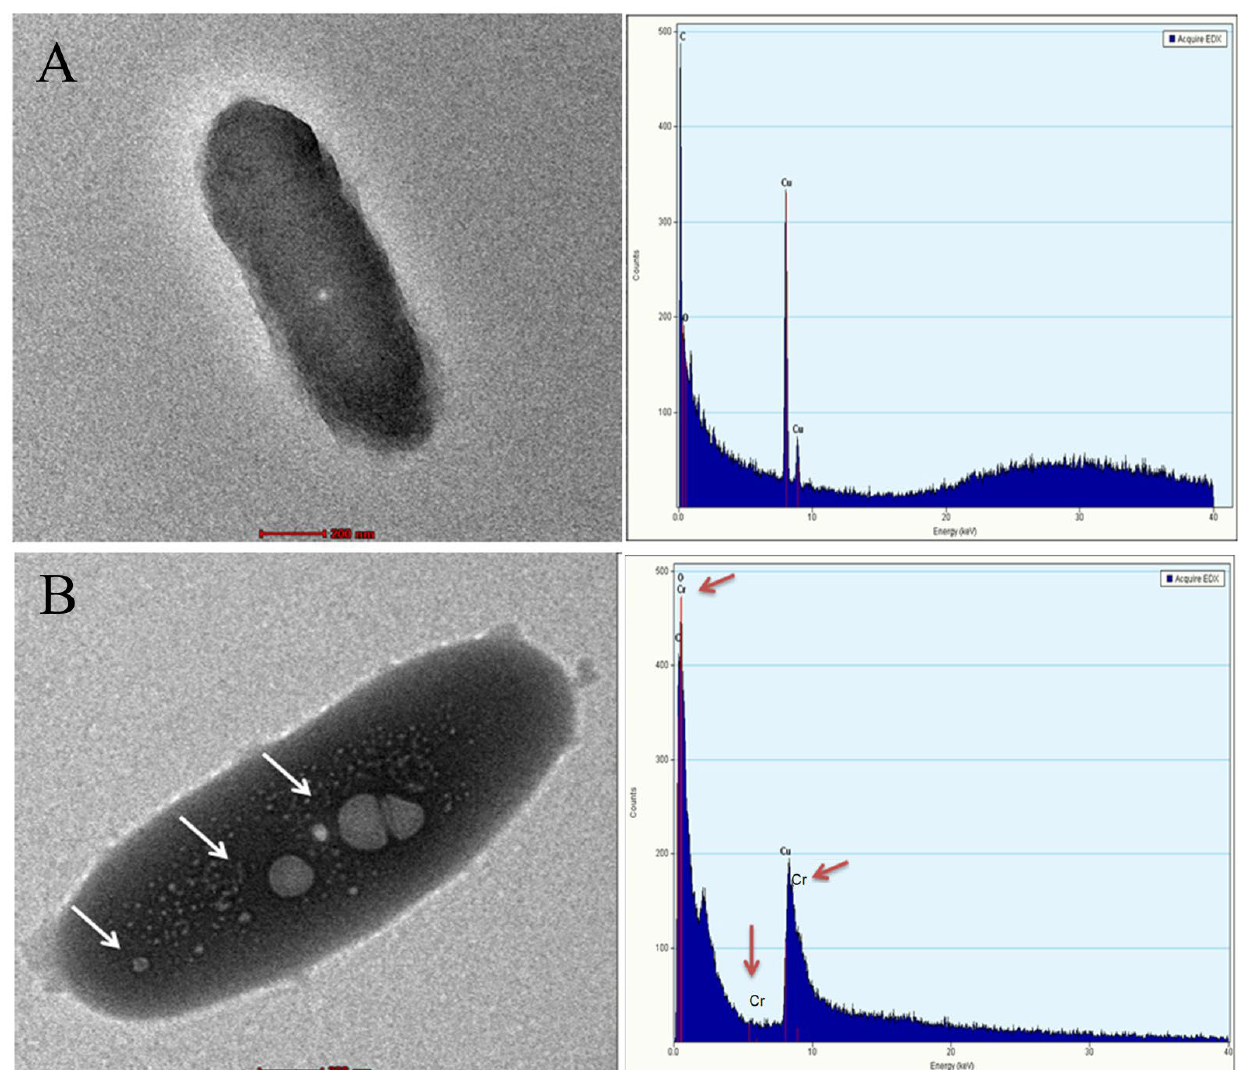
Figure 4. TEM—EDX image of ( A ) Control and ( B ) Cr(VI)-treated cell. (White arrows in the TEM image indicate the intracellular accumulation Cr; red arrows in EDX spectrum indicate the presence of Cr).